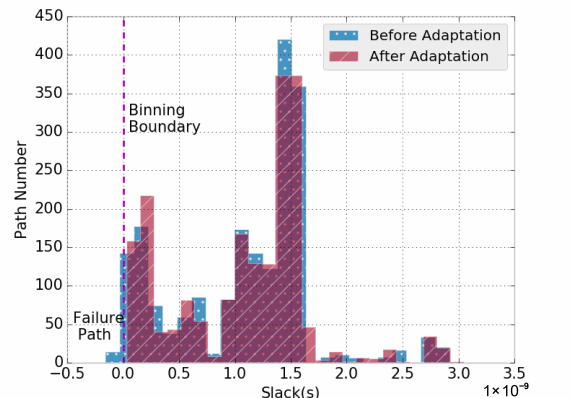
Figure 9. The slack distribution of a ITC’99 b19 sample, with 94 paths fail 167 MHz binning. With all failure paths correctly adapted, this sample is successfully promoted to the 167 MHz